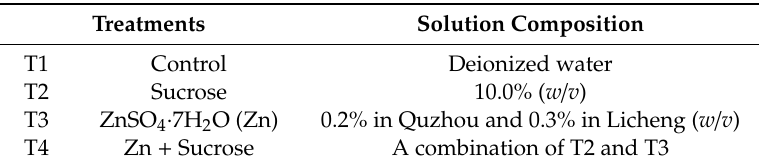
Table 2. Foliar spraying